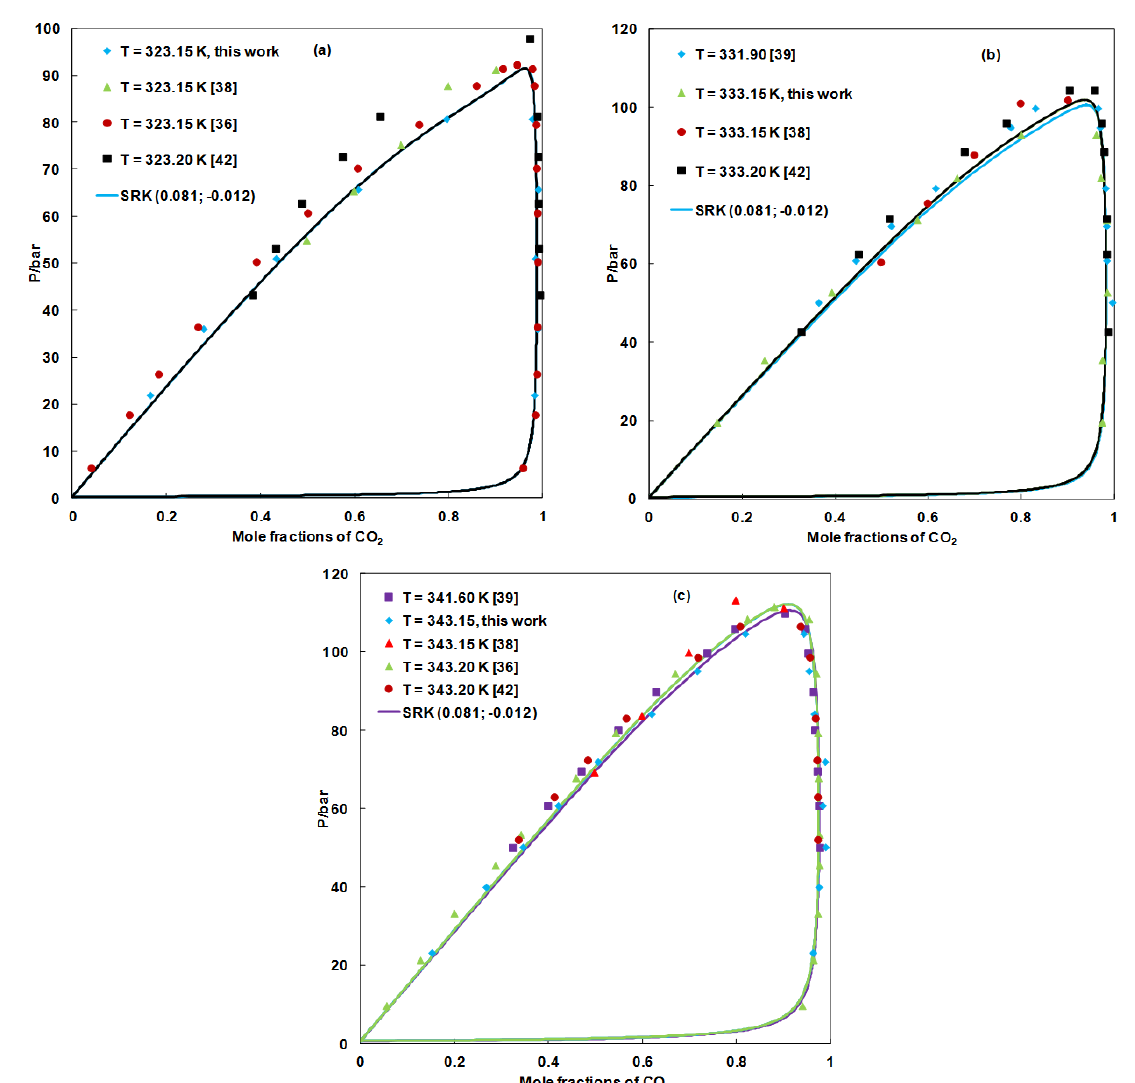
Figure 1. Comparison of new measured and literature data for the carbon dioxide + 2-methyl-2-propanol ( tert -butanol) system and calculations by SRK model: symbols, this work and literature data at different temperatures; solid lines, predictions by SRK ( k